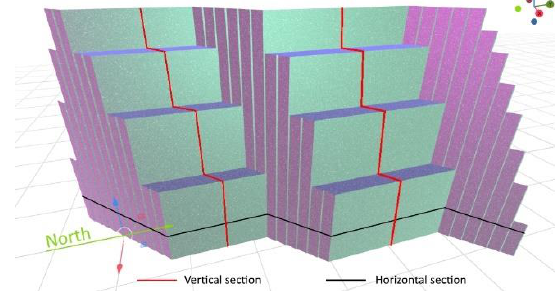
Figure 4. Synthetic outcrop created with Blender (2019)